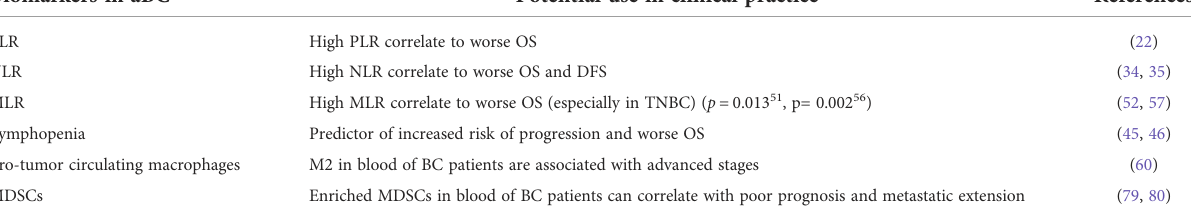
TABLE 1 Lists of various potential new biomarkers and implication in clinical